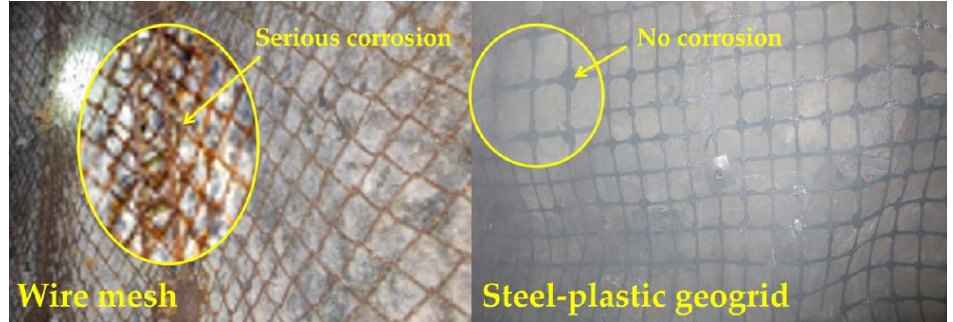
Figure 18. Comparison of mesh erosion and corrosion.